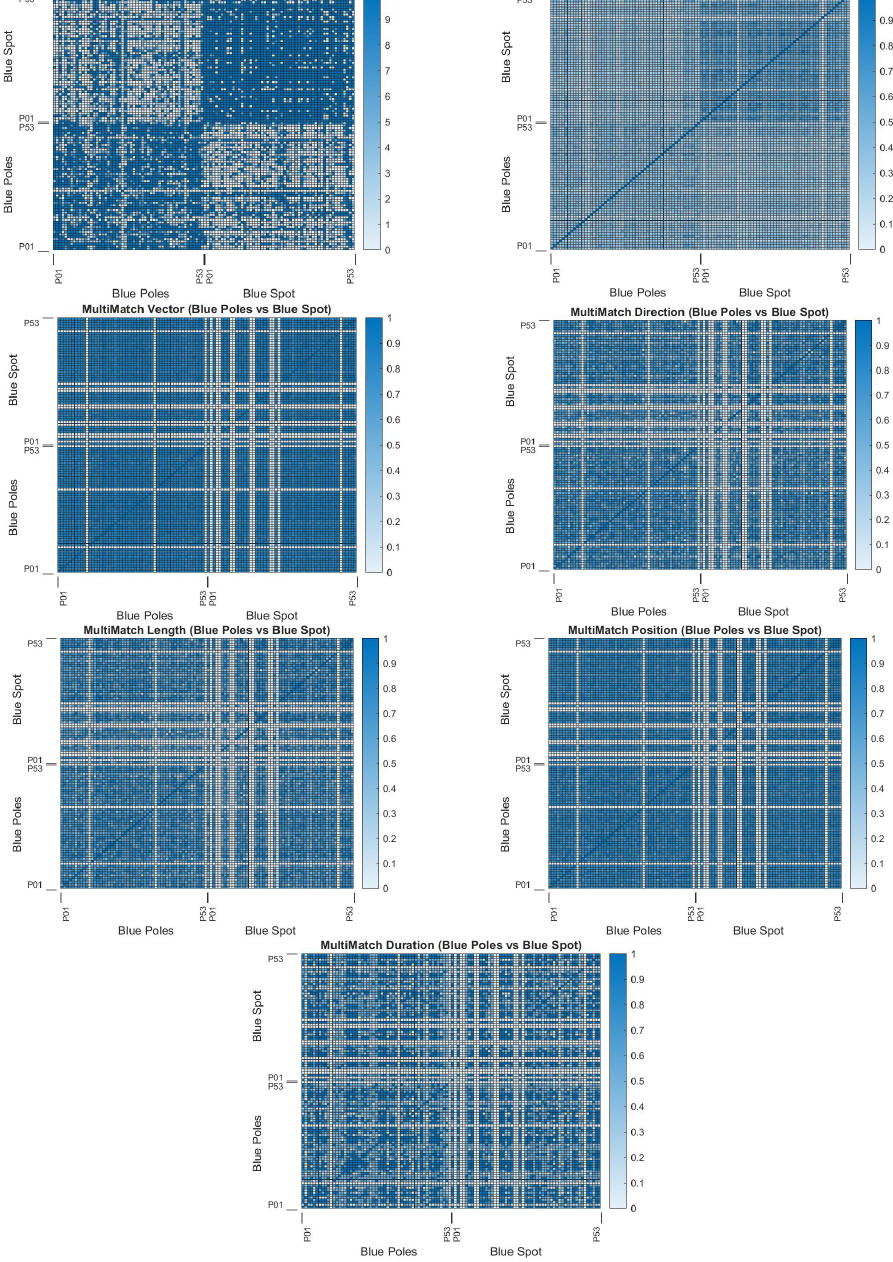
Figure A1. SoftMatch, ScanMatch, and MultiMatch heatmaps for empirical evaluation. Stimuli matched are Jackson Pollock’s Blue Poles (1952) and Bernard Cohen’s Blue Spot